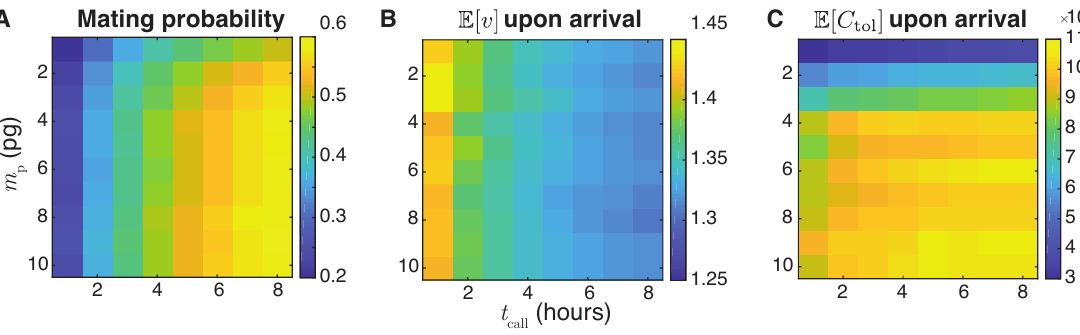
Figure 12. Simulation results from the agent-based Plume Navigation Model described in Section 5 for N = 10,000 moths. The range of the male quality trait C tol is 10 − 10 to 10 − 6 pg/m 2 ; for v , it is 0.5 to 2 m/s. ( A ) Contour plot of mating probability as a function of female calling effort in { t call , m p } phase space, regardless of male quality: The panel tallies moths with all levels of C tol and v that reach the female. ( B ) Contour plot of the mean speed E [ v ] of males upon reaching the female in { t call , m p } phase space and for any level of male C tol . ( C ) Contour plot of the mean detection threshold E [ C tol ] of males upon reaching the female in { t call , m p } phase space for any level of male v . Male arrival likelihood is highly dependent on t call : modulating t call allows the female to select for male speed v , and modulating m p allows the female to select for C tol